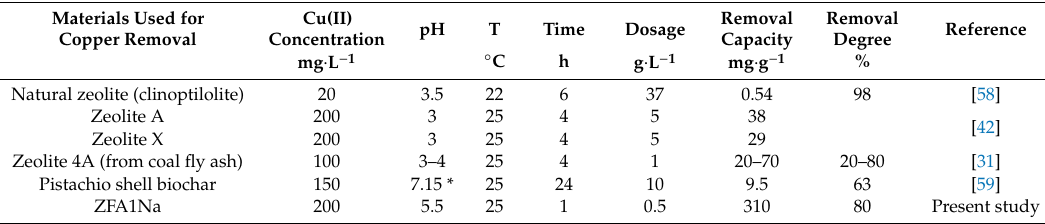
Table 4. Data on Cu(II) and Zn(II) (initial concentration values) removal by zeolite-type